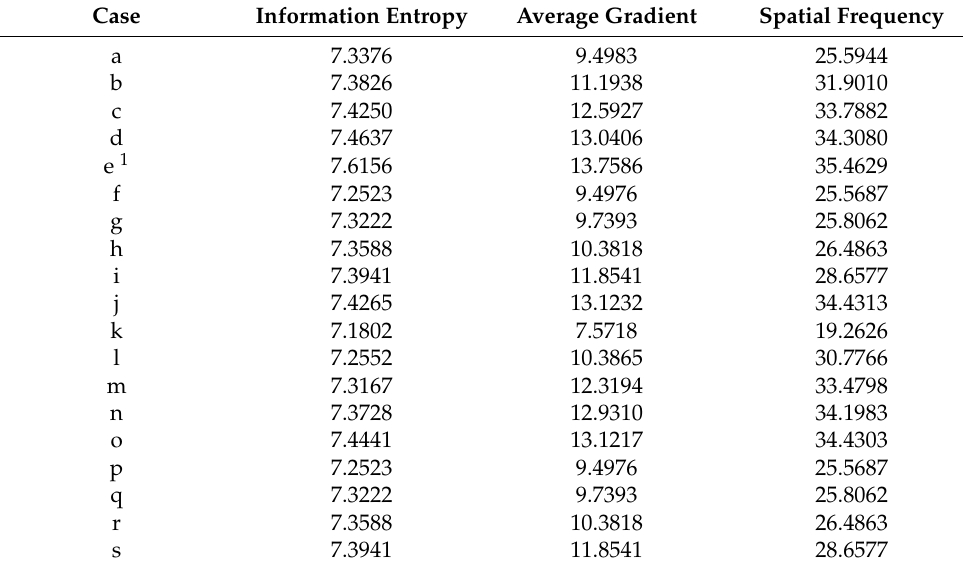
Table 3. Comparison of fusion effects in different combinations.